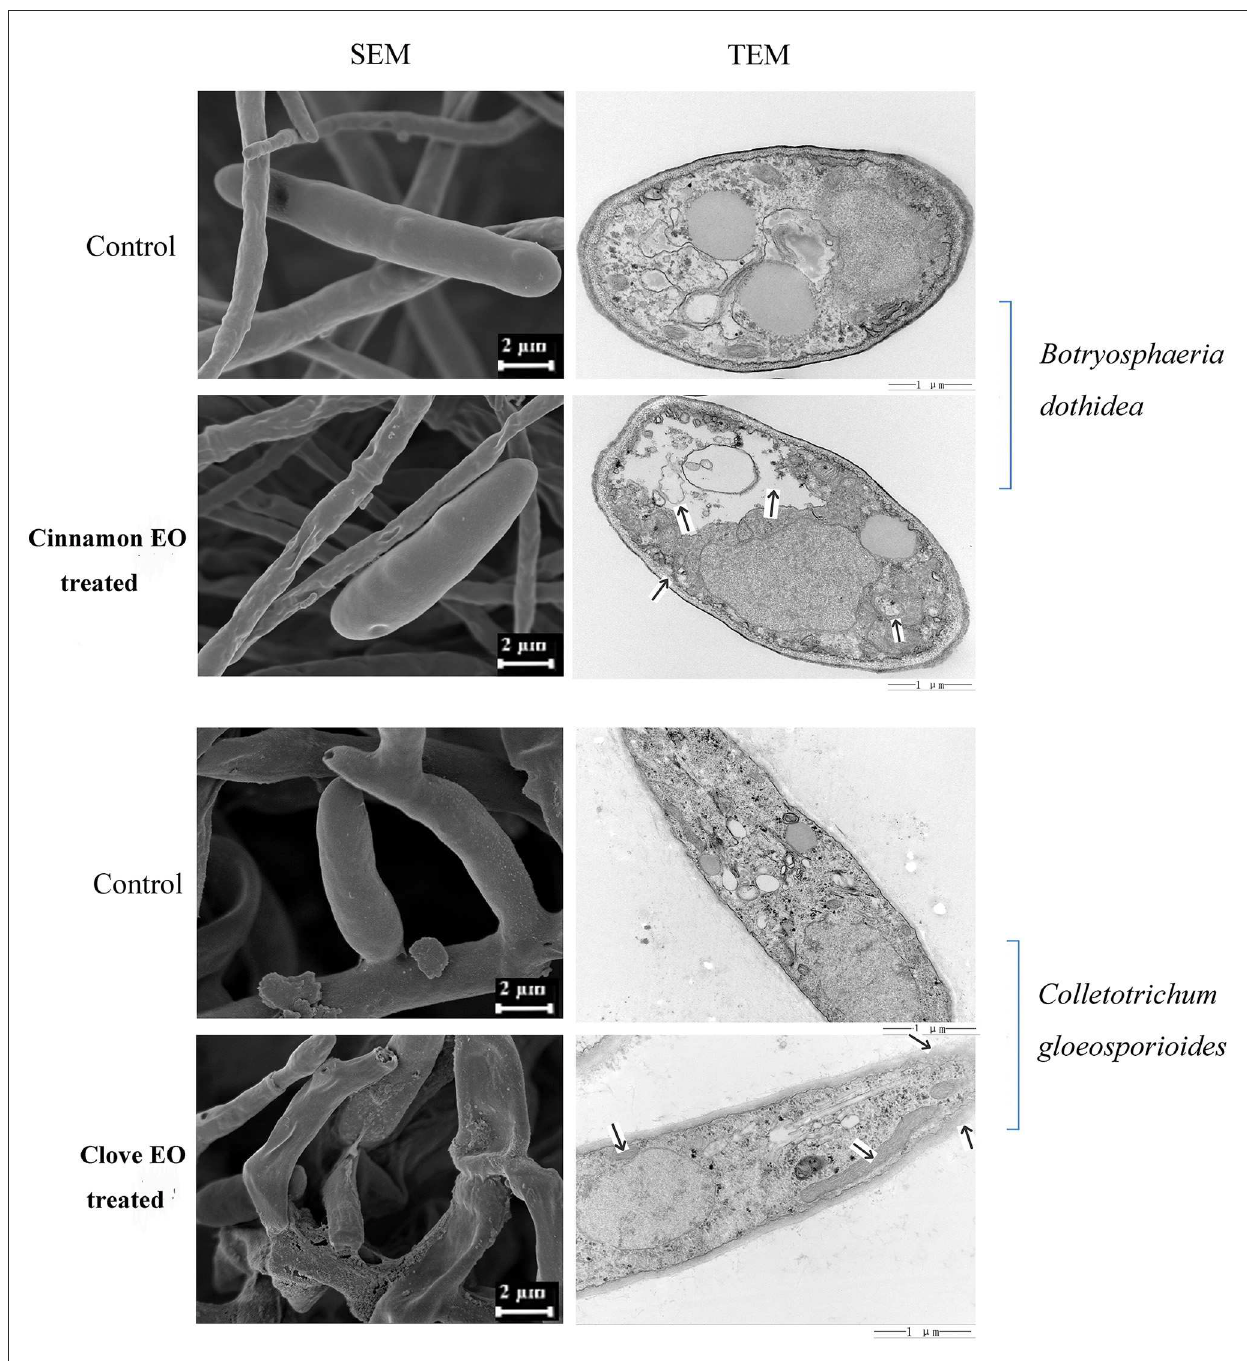
FIGURE5 SEM and TEM micrograph of pathogen cells treated and untreated with EOs.